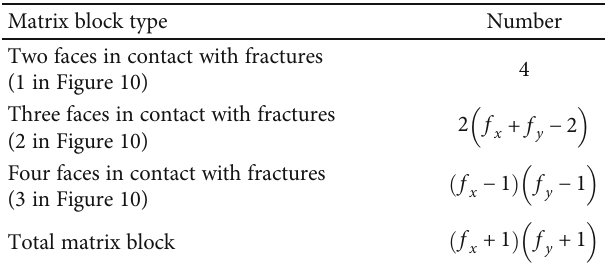
Figure 11: Top view of the fracture network model of a volumetric fractured well. Table 2: Categories of matrix